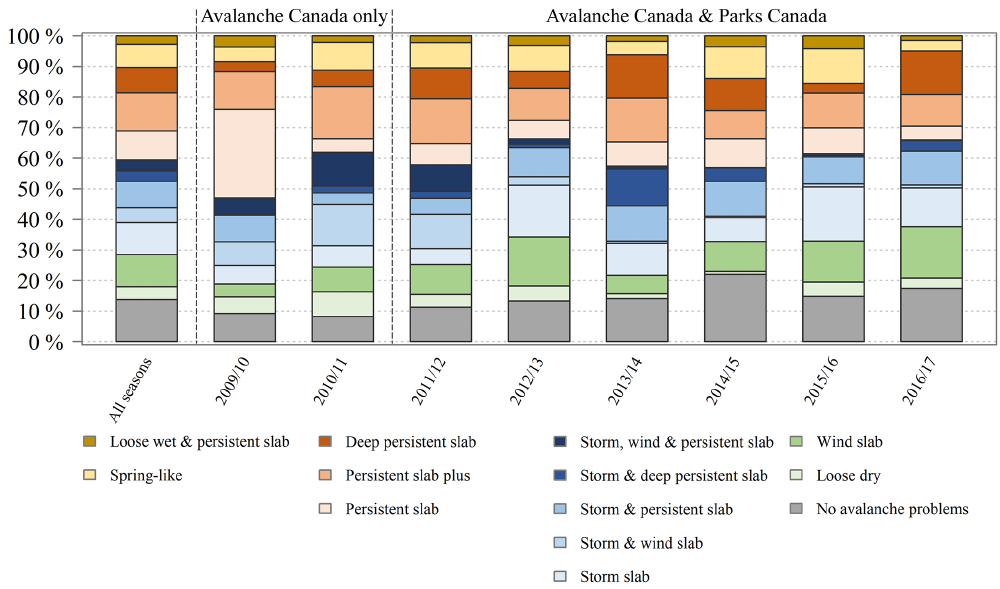
Figure 4. Inter-seasonal variability of typical hazard situation prevalence.